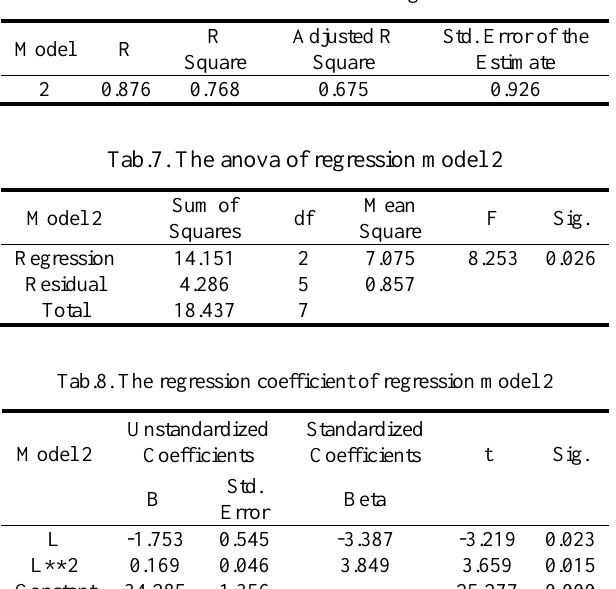
Tab.6. The determinant coefficient of regression model 2